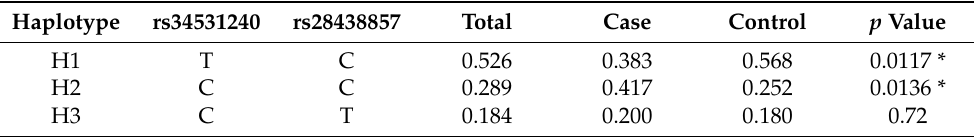
Table 6. Haplotype analysis for NLRP3 gene polymorphisms in IPA